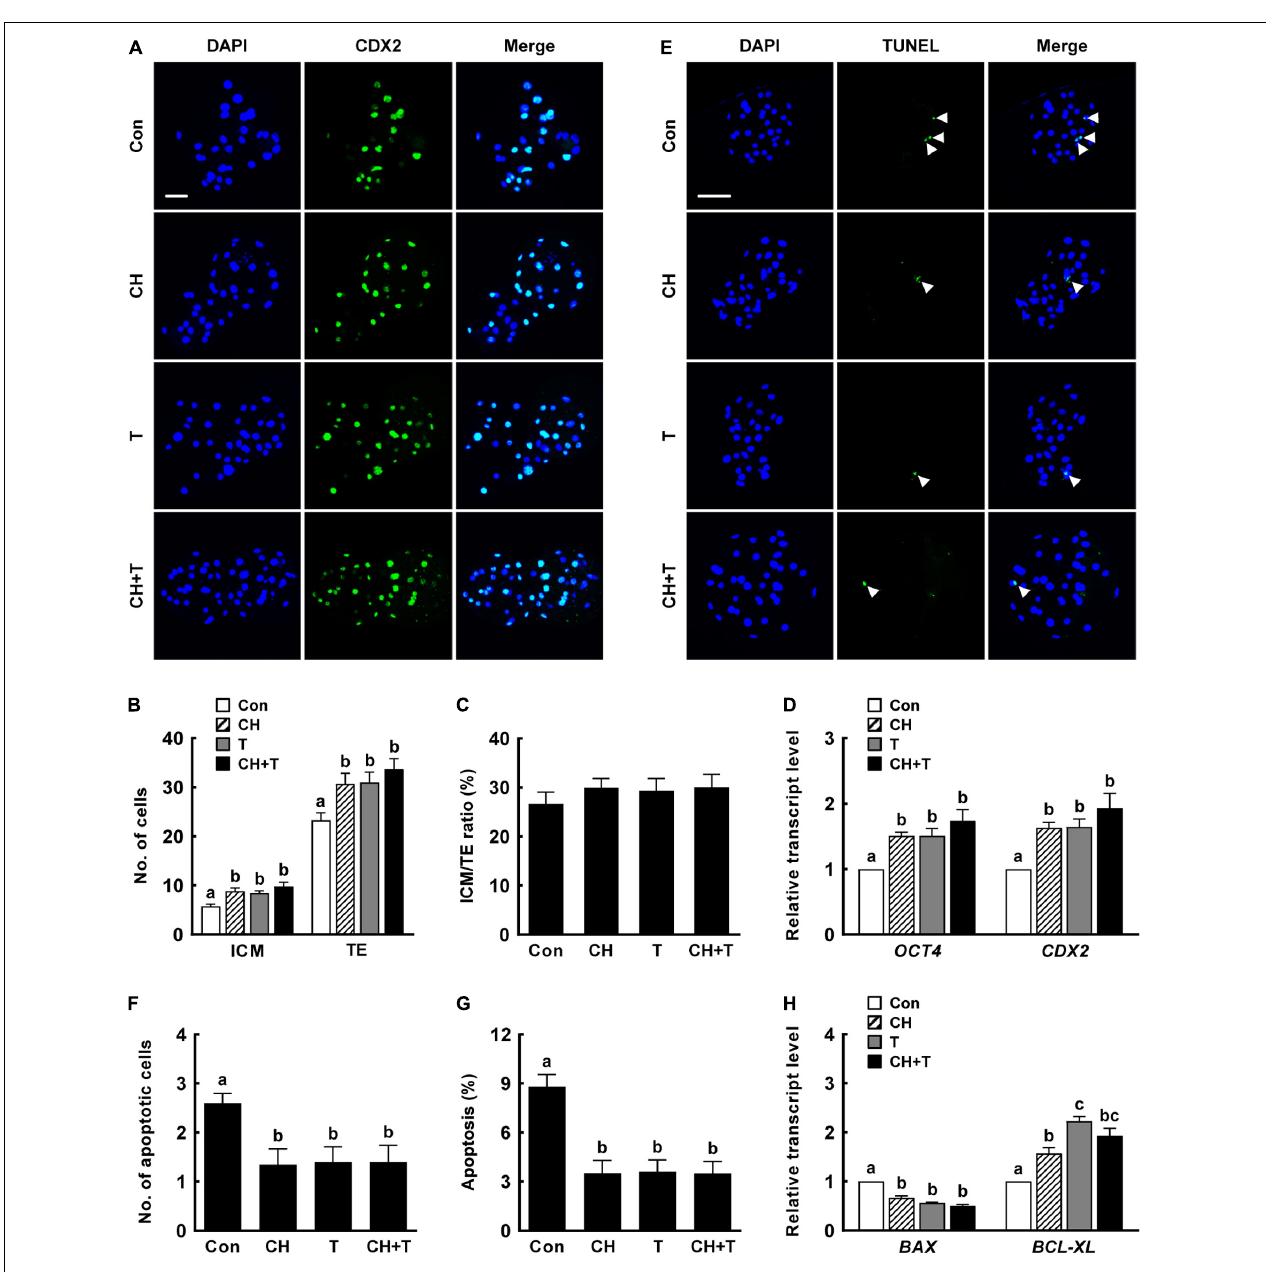
FIGURE 2 | Effects of chaetocin, TSA, and the combination on the developmental competence of porcine SCNT embryos. (A) Representative immunofluorescent images of CDX2/DAPI-stained blastocysts. Green and blue fluorescence indicate CDX2 and nuclei, respectively. Bar = 50 µ m. Quantification of (B) ICM and TE cell numbers and (C) ICM/TE ratios ( n = 20 per group). (D) qRT-PCR data on embryonic development-related gene expression in blastocysts ( n = 3 per group). (E) Representative TUNEL assay images of blastocysts. Green and blue fluorescence indicate the TUNEL label (white arrow) and nuclei, respectively. Bar = 50 µ m. Quantification of (F) the apoptotic cell number and (G) the apoptosis rate ( n = 20 per group). (H) qRT-PCR data on apoptosis-related gene expression in blastocysts ( n = 3 per group). The data are from three independent experiments and are means ± SEM. Values with different superscripts differ significantly ( P < 0.05).